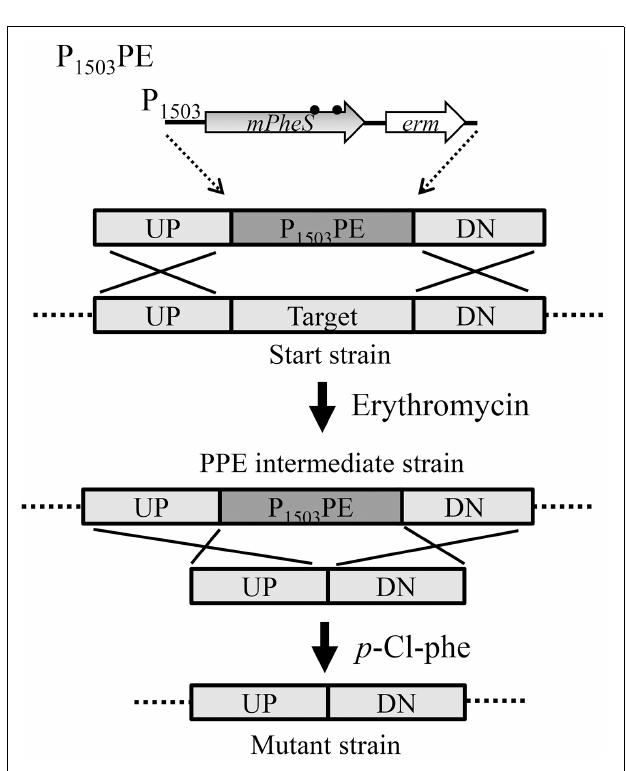
FIGURE 5 | Diagram for the two-step markerless gene-deletion strategy developed for S. suis in this study, using erm as a positive-selection marker and P 1503 - mPheS as a